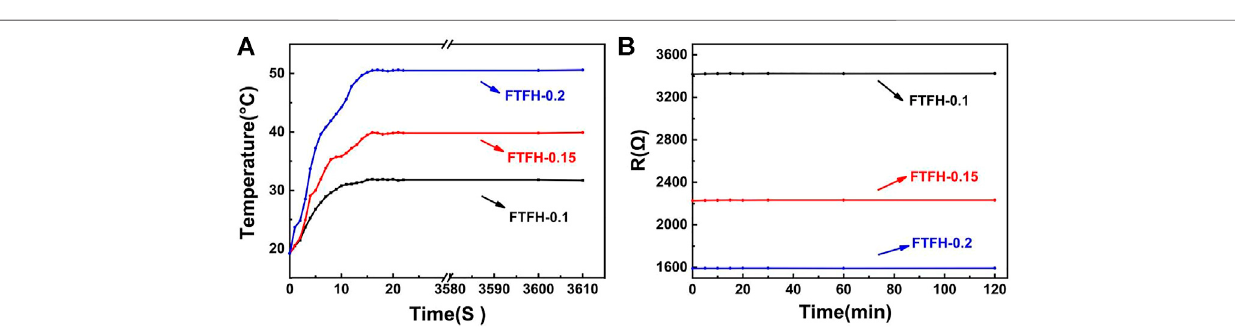
TABLE 3 | Comparison with other fi lm heaters as previously